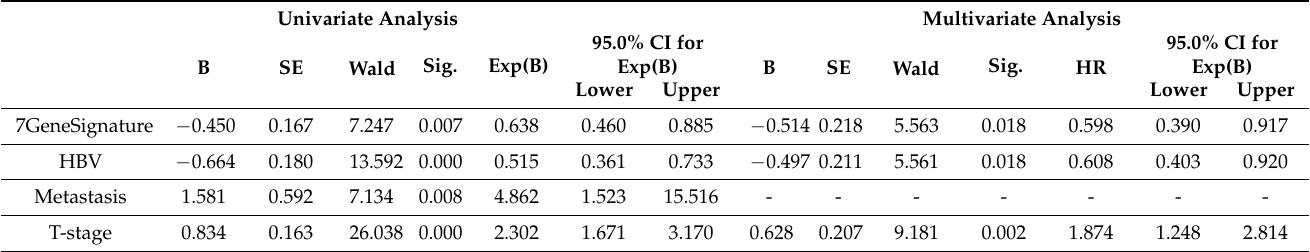
Table 4. Cox Regression Analysis for disease free survival (Validation